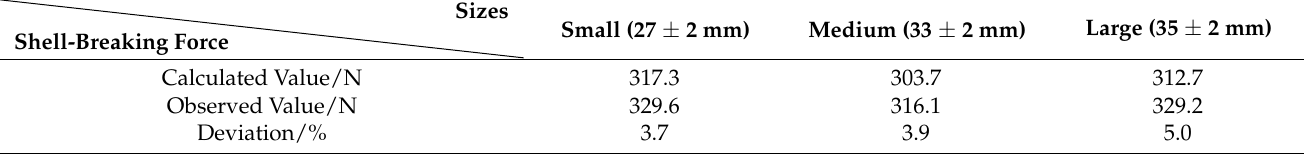
Table 2. Shell breaking force